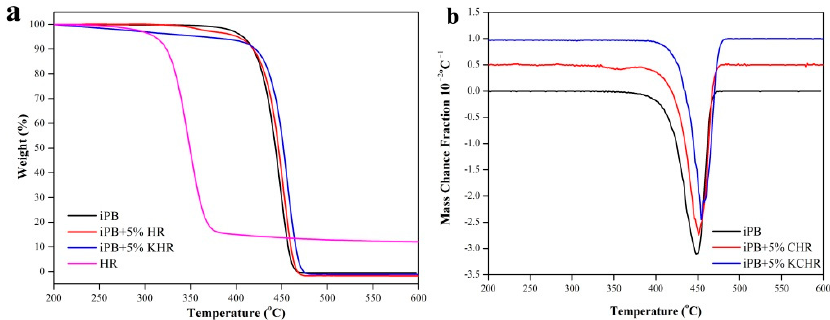
Figure 6. The TG and DTG curve of the iPB/HR composite. (( a ). TG curve; ( b ). DTG curve).